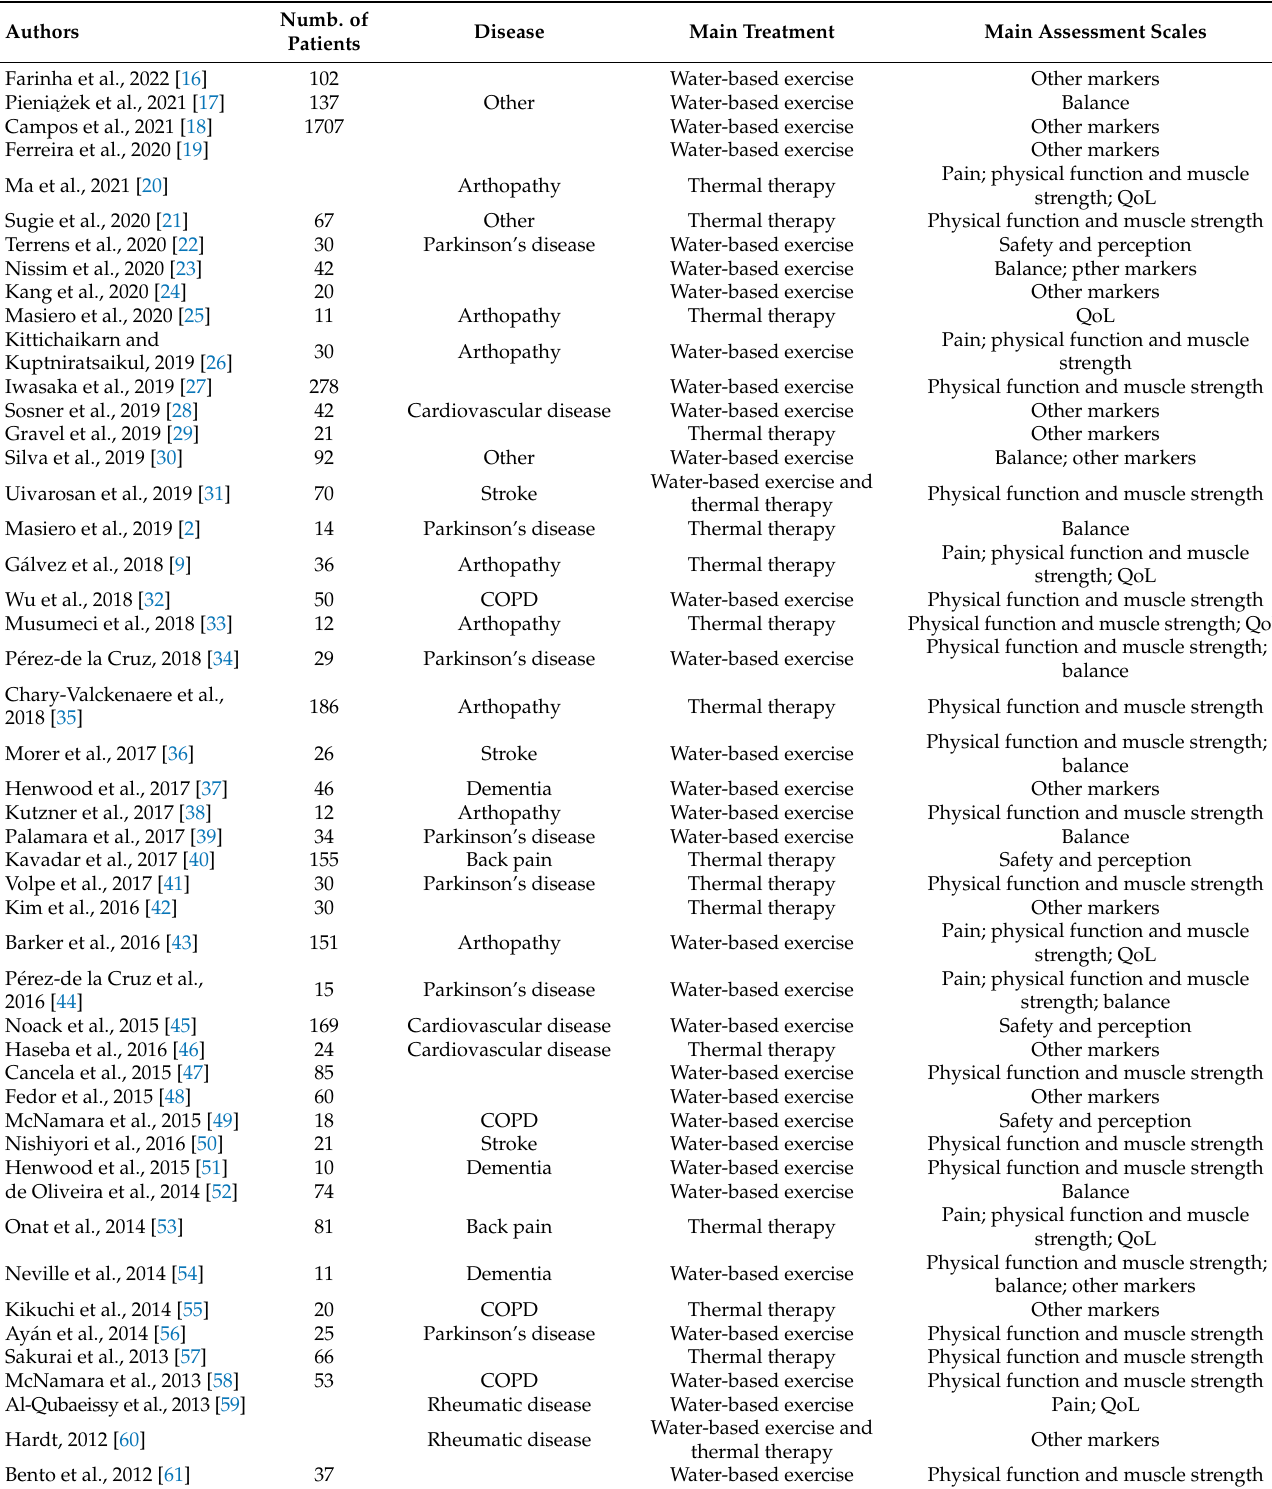
Table 1. Results of the literature analysis after the selection of the 49